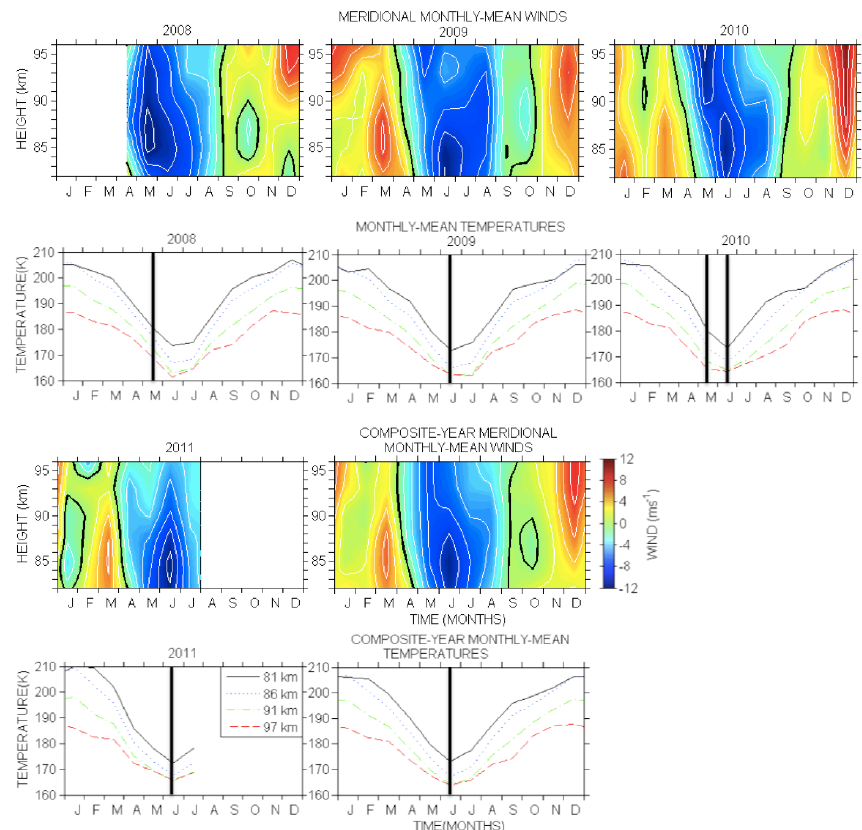
Fig. 1. Monthly-mean meridional winds over BLO and monthly-mean Aura MLS temperatures. The zero wind contour is indicated in black and the white contours are in steps of 2ms − 1 . The temperatures are means for a latitude/longitude “box” of 40–45 ◦ N, 90–120 ◦ W for four height gates between on ∼ 81–97km. The black vertical lines on the temperature plots indicate time of minimum meridional winds.